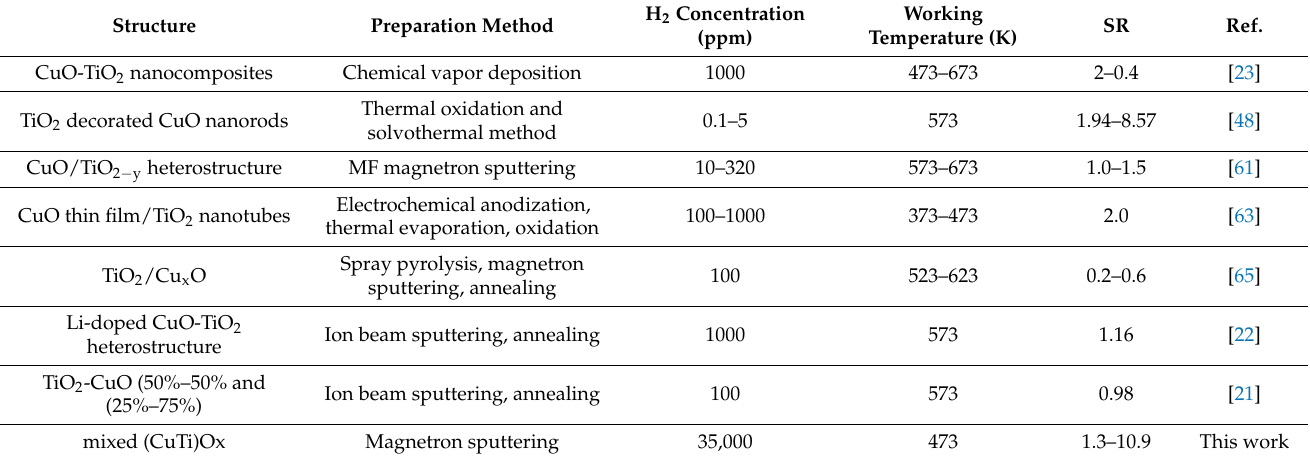
Table 5. Gas sensing performance of copper oxide and titanium oxide composites toward